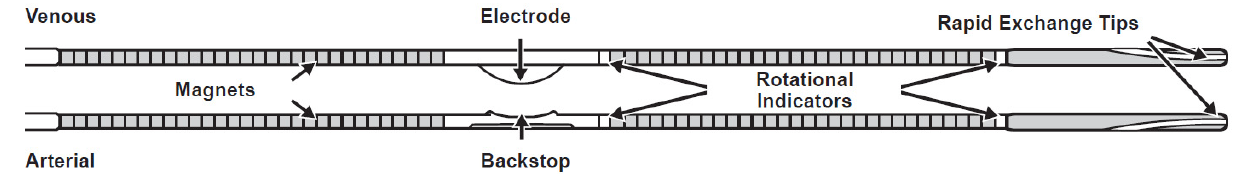
Figure 2. WavelinQ TM Venous Catheter with Electrode and Arterial Catheter with Backstop.